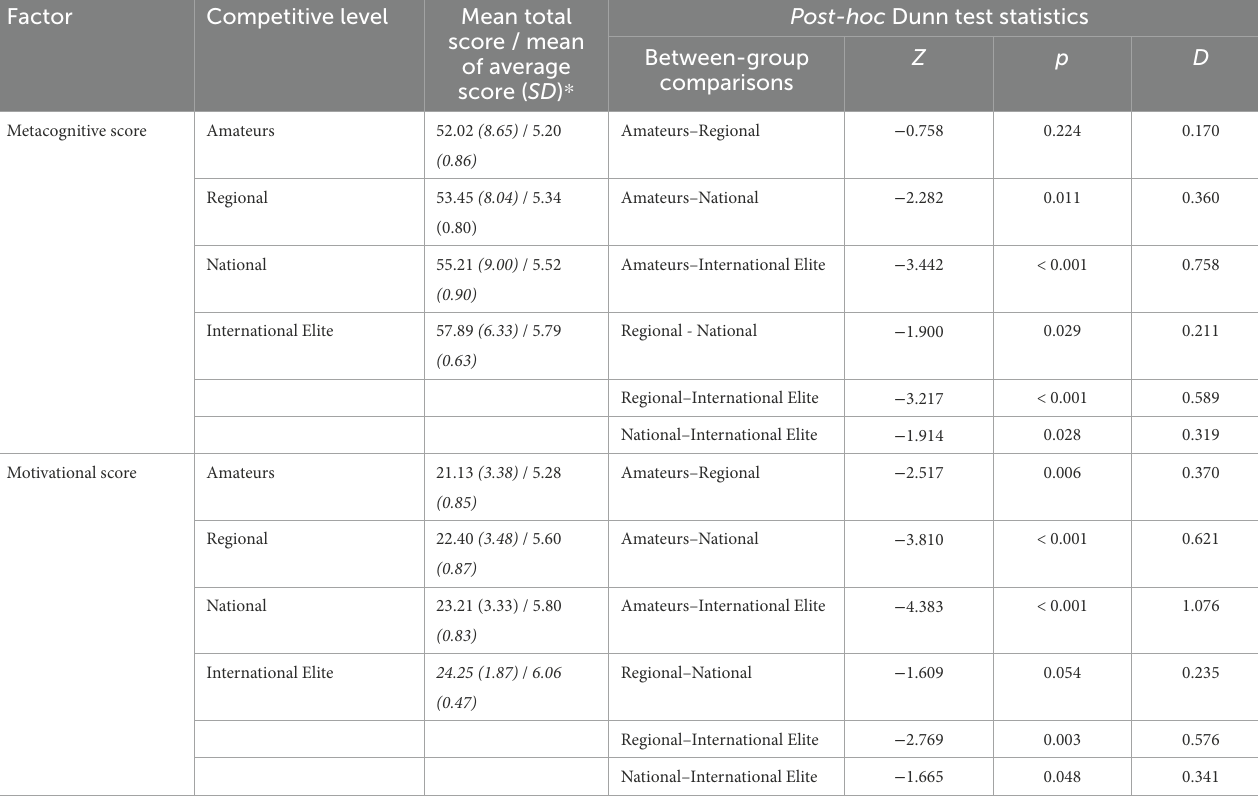
TABLE 2 Inter-group data for scores on the metacognitive and motivational subscales of the Polish Short Form SRL-SP. Factor